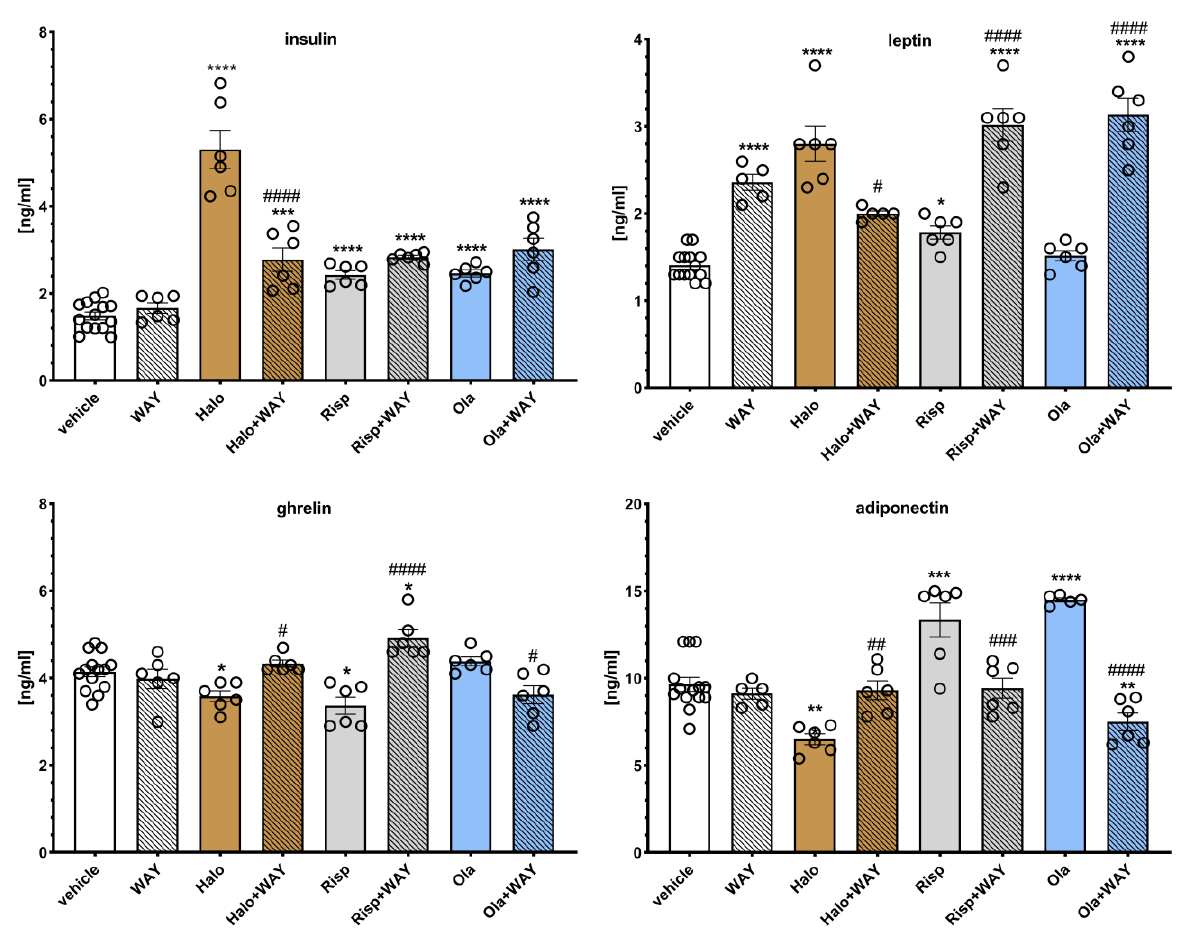
Figure 7. Effects of haloperidol, risperidone, olanzapine, and WAY-181187, administered alone and in combinations, on the serum levels of insulin, ghrelin, leptin, and adiponectin in rats. The results are presented as mean ± SEM; n = 6 – 12. * p < 0.05, ** p < 0.01, *** p < 0.001, **** p < 0.0001 versus the respective vehicle-treated group; # p < 0.05, ## p < 0.01, ### p < 0.001, #### p < 0.0001 versus respective APD-treated group (two-way ANOVA followed by Bonferroni’s post hoc test). Halo, haloperidol 0.5 mg/kg; Risp, risperidone 0.5 mg/kg; Ola, olanzapine 5 mg/kg; WAY, WAY-181187 3 mg/kg.